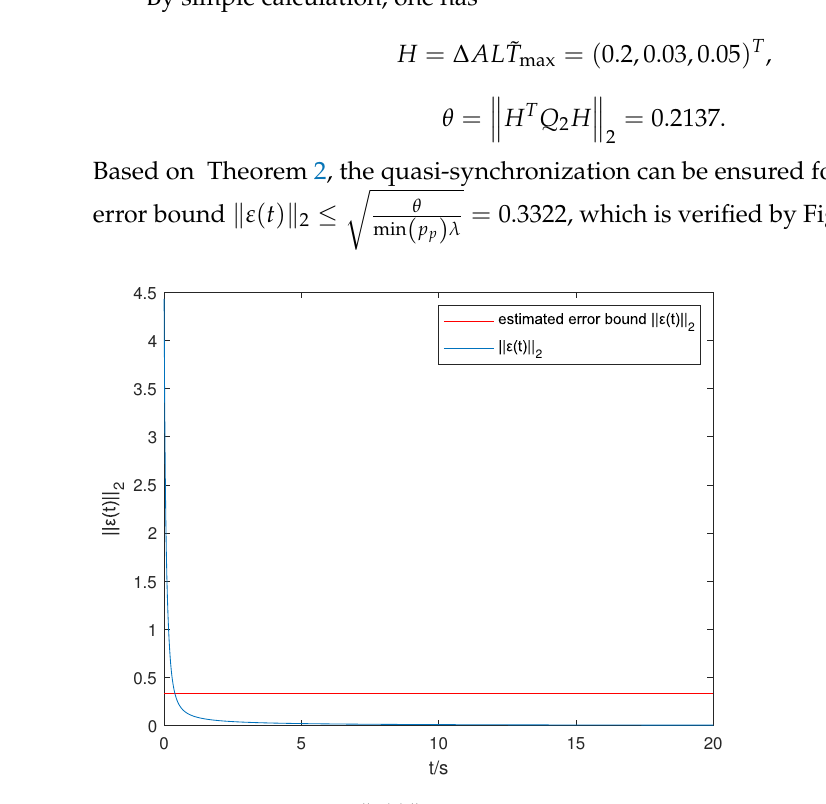
Figure 5. Error bound and (cid:107) ε ( t ) (cid:107) 1 of Example